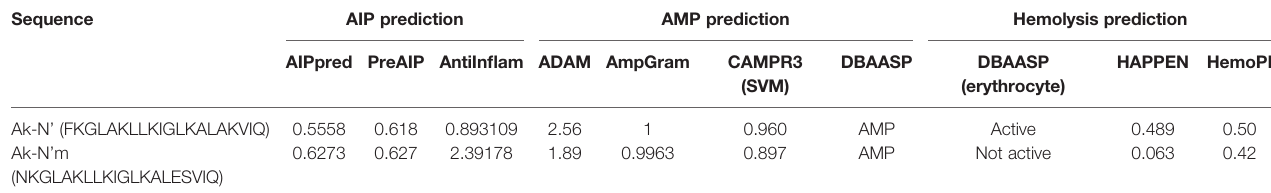
TABLE 1 | Functional prediction of Ak-N ’ and Ak-N ’ m using machine learning-based tools. Sequence